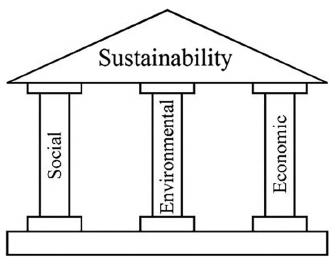
Fig. 1. The Three Pillars of Sustainability (according to SP